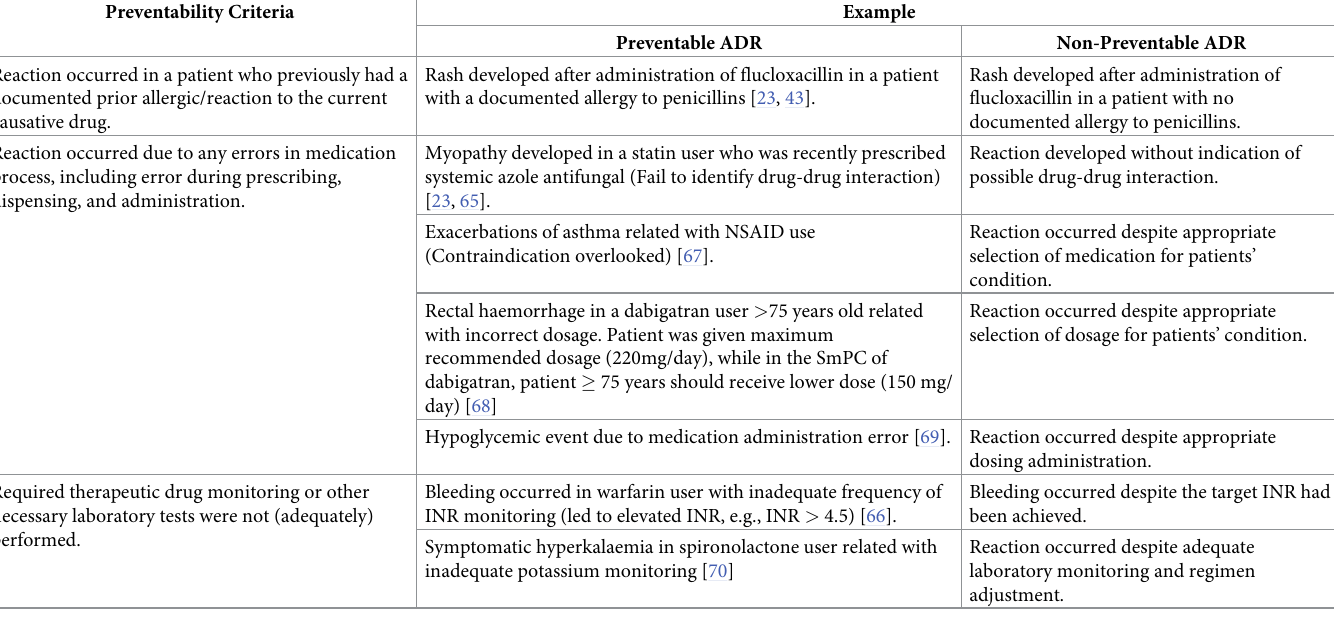
Table 2. Example of preventable and non-preventable adverse drug reactions. Preventability